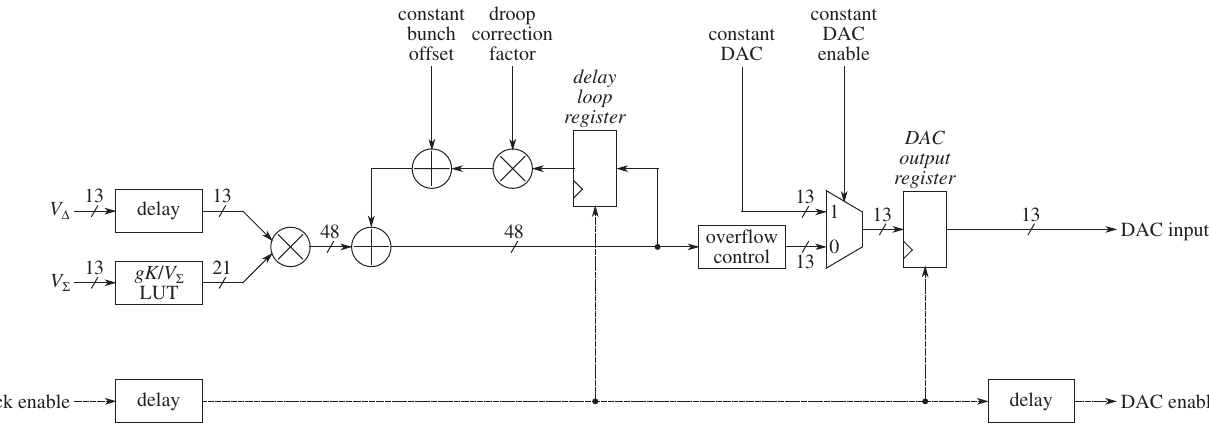
FIG. 11. Simplified representation of the feedback signal processing architecture on the FPGA. The signal bus lines are annotated to show the number of bits represented at each stage of the processing. Note that, for simplicity, clock signals are not shown in the diagram, and hence the schematic does not represent the actual timing of the feedback processing.